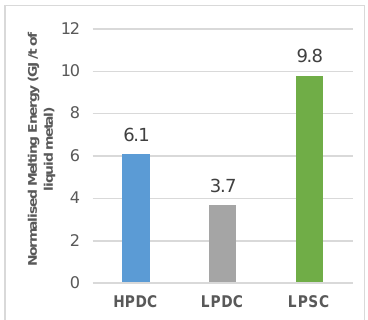
Figure 16. Melting energy per ton of liquid metal in three different Al foundries.